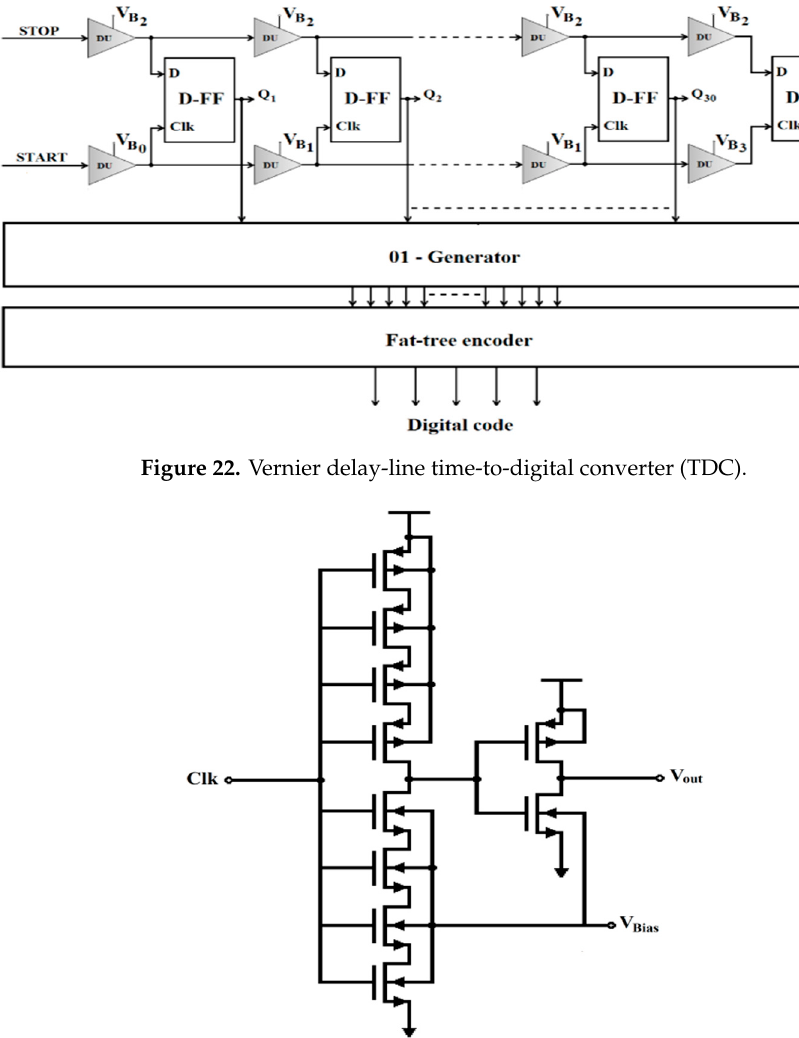
Figure 23. Delay unit for the first proposed ADC.